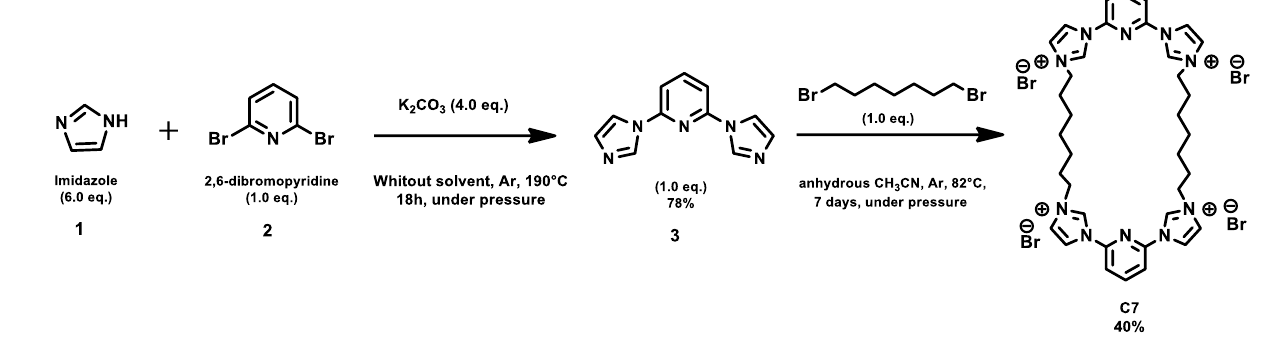
Figure 12. Chemical synthesis pathway of C7.